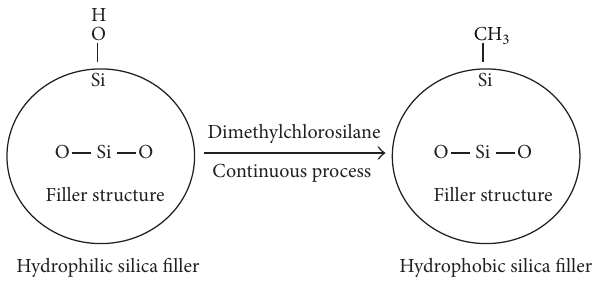
Figure 1: Hydrophobic silica